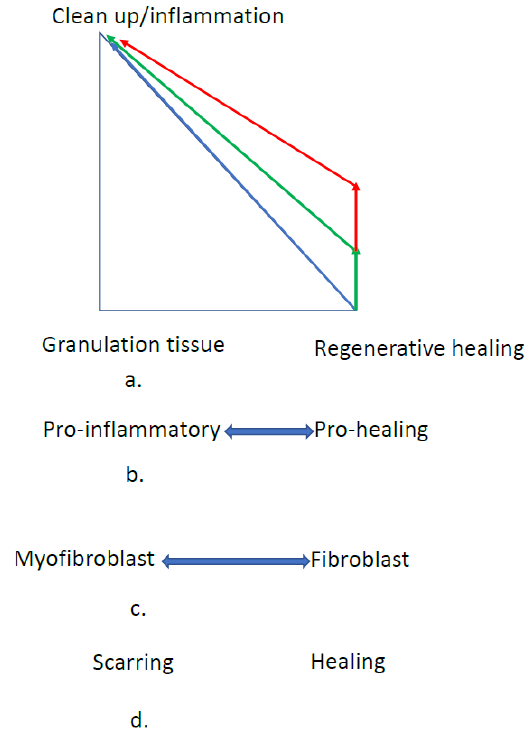
Figure 1. Cell and tissue changes during the repair phase of wound healing. ( a ). As the amount and time of inflammation increases (mostly due to cleaning up of the wound), the higher percentage of healing is granulation tissue. Part of the theory proposed is that animals that are more regenerative would require more clean-up/inflammation before increasing the percentage of granulation tissue formed (green and red lines). ( b ). As the amount and time of inflammation increases (mostly due to cleaning up of the wound), a higher and higher percent of macrophages are pro-inflammatory vs. pro-healing. Again, animals that are more regenerative would probably require more clean-up/inflammation before increasing the percentage of pro-inflammatory macrophages (green and red lines). ( c ). The ratio of pro-inflammatory macrophages to pro-healing macrophages should control the ratio of myofibroblasts to fibroblasts, which in turn will control the ratio of granulation tissue to regenerative healing ( a ), which will control the ratio of scarring to healing ( d ) [14]. It is also likely that the higher the level of pro-inflammatory macrophages, the longer